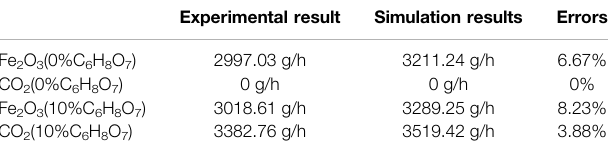
TABLE 3 | Content comparison at outlet.